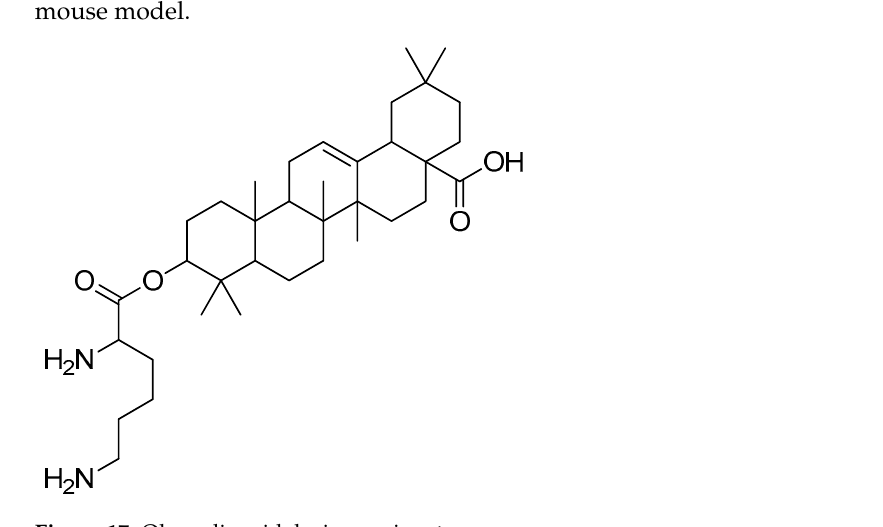
Figure 17. Oleanolic acid–lysine